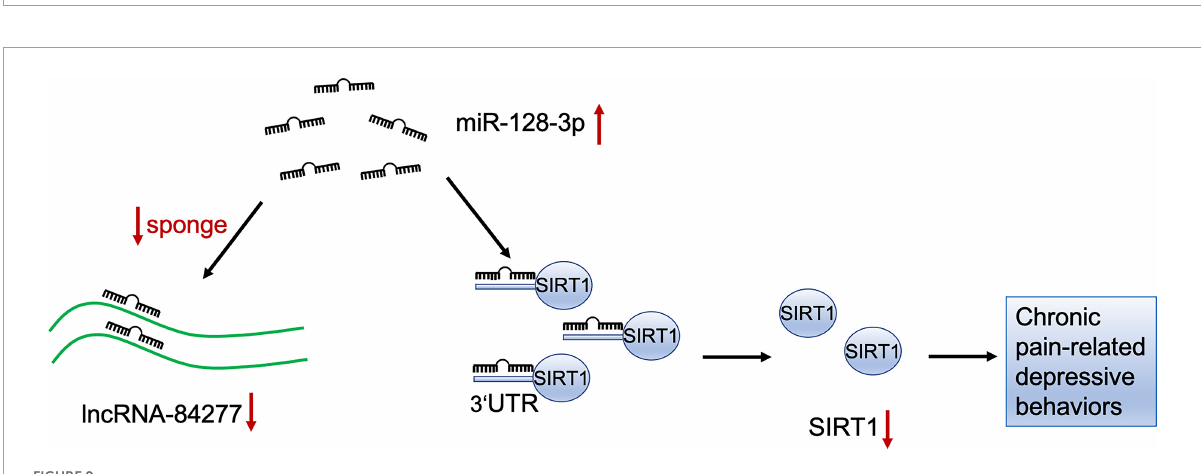
FIGURE9 The schematic diagram of the mechanism of lncRNA-84277/miR-128-3p/SIRT1 axis in chronic pain-related depression. LncRNA-84277 downregulation contributes to chronic pain-related depression-like behaviors by increasing the endogenous inhibitory effect of miR-128-3p on